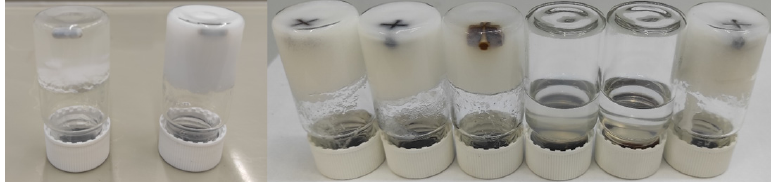
Figure 1. Gelation behavior of 1-Ala in various solvents in order from left: in toluene (transparent gel), water, t-BuOMe, petroleum ether (120–140 °C), CHCl 3 (opaque gels), no gelation in alcohols gel), water, t-BuOMe, petroleum ether (120–140 ◦ C), CHCl 3 (opaque gels), no gelation in C 2 H 5 OH and n-C 5 H 11 OH, and finally a gel in a mixture of water/ethyl alcohol (6/4 v / v ).